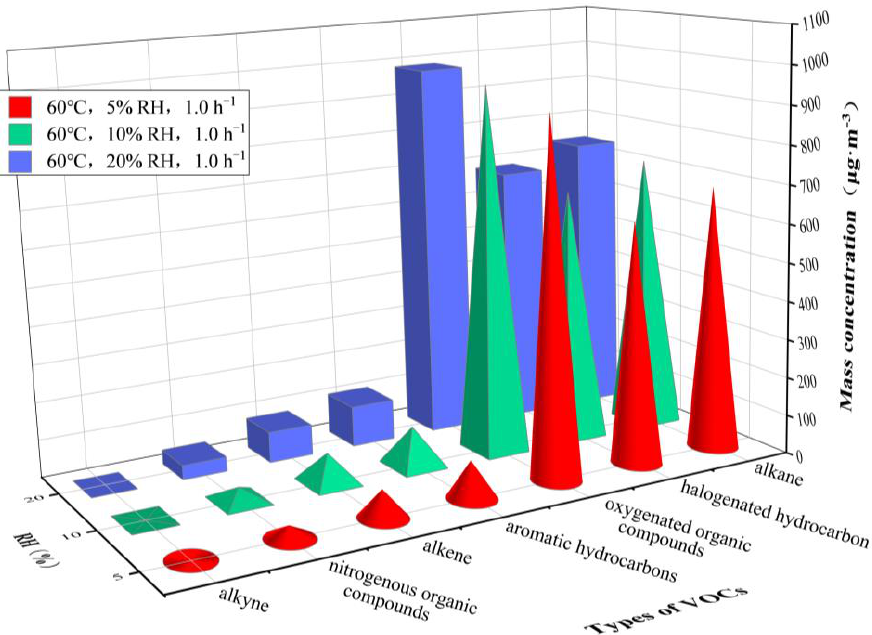
Figure 7. Mass concentrations of VOCs released from plastic track at RHs varying from 5 to 20%. Temperature = 60 °C and AER = 1.0 h −1 .